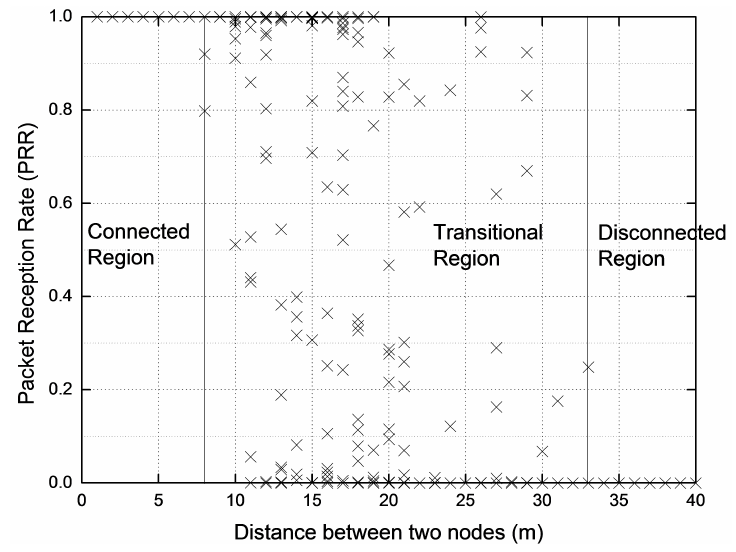
Figure 1. Packet reception rate of considered link loss model at different